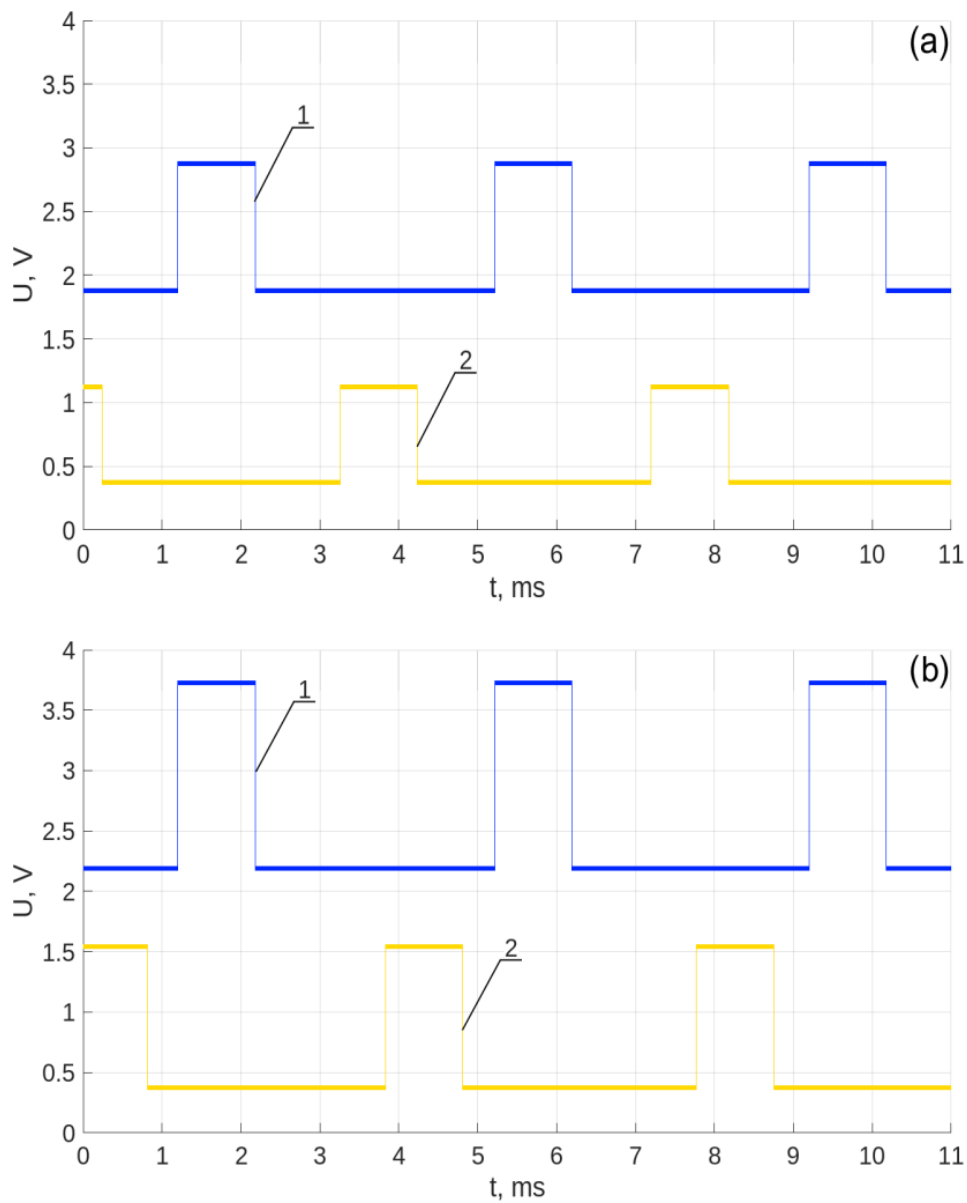
Figure 6. Rectangular pulses for the transmission of digits in numbers as a sequence of command codes: graph 1 at the input to 2, graph 2 at the output 3. Studies are presented for various values of L in km: ( a ) − 200; ( b ) − 250.